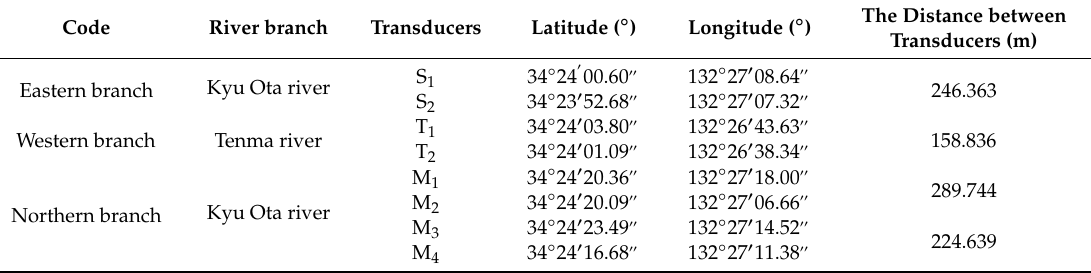
Table 2. Coordinates of